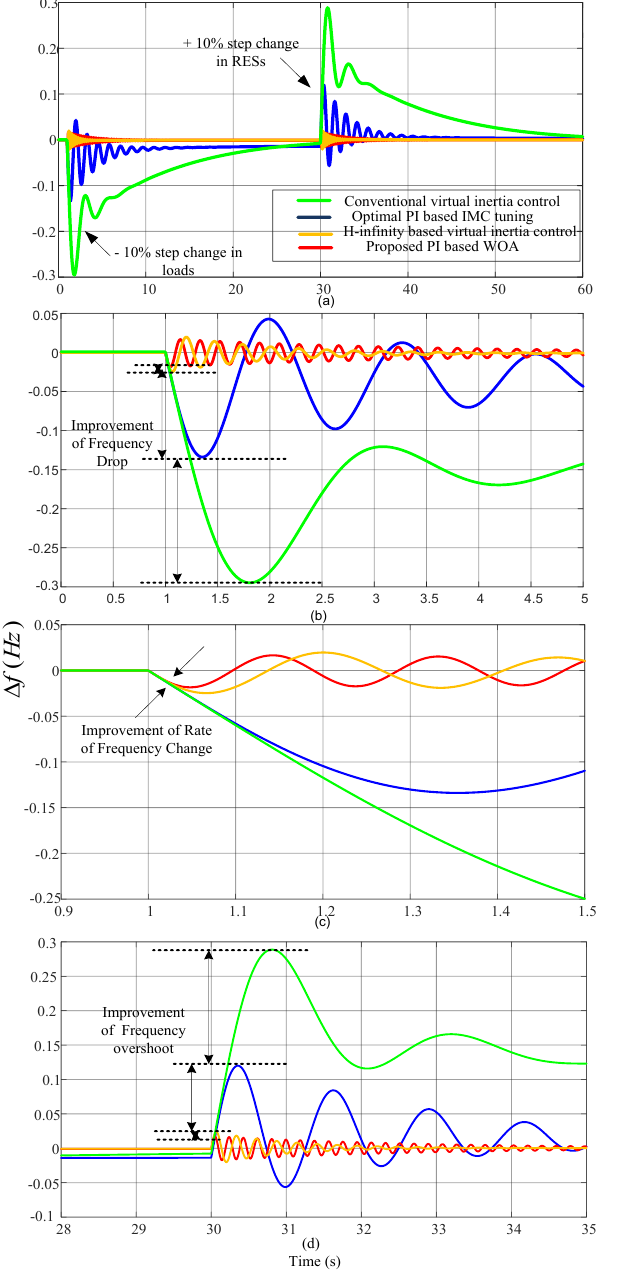
Figure 8. Microgrid frequency performance: ( a ) Frequency stability. ( b ) Frequency drop. ( c ) RoCoF. ( d ) Frequency